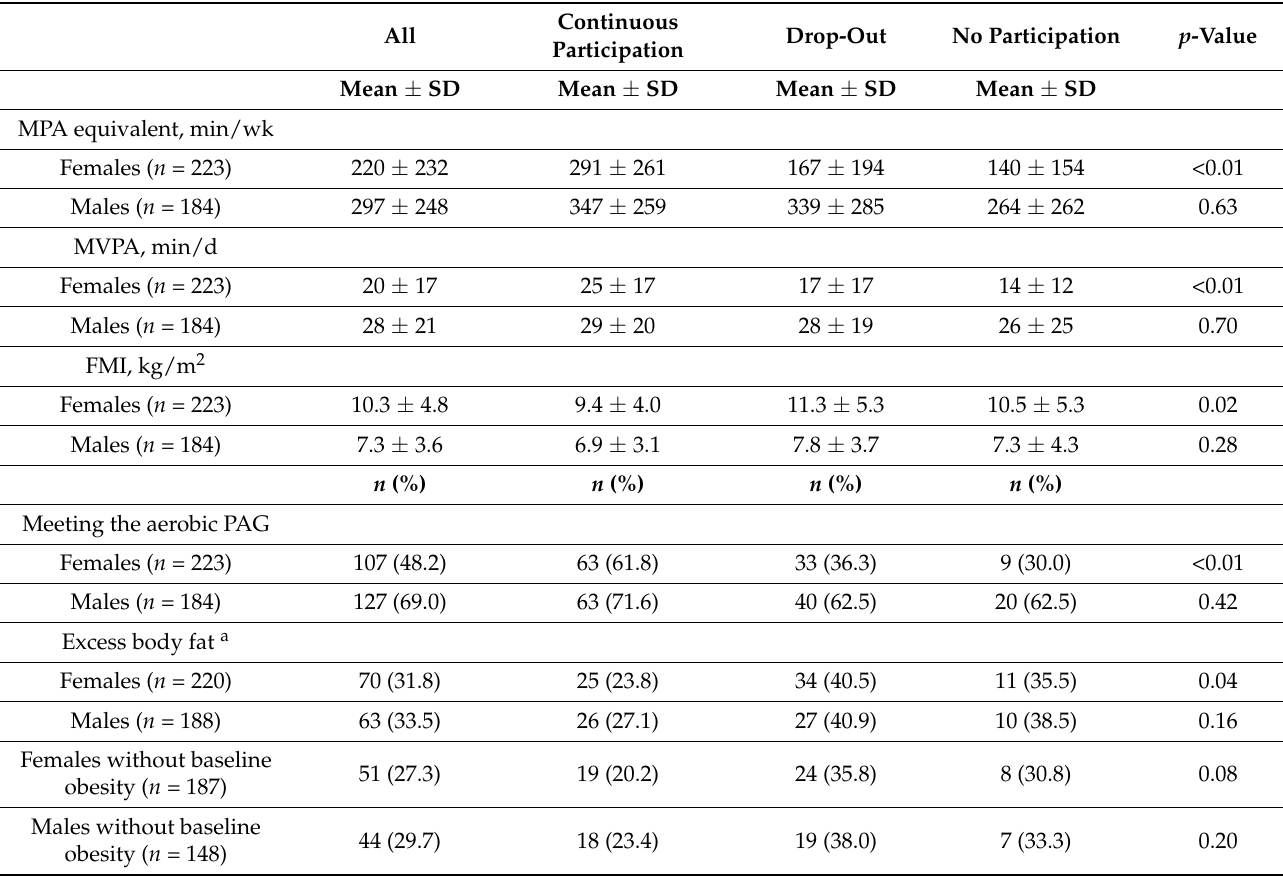
Table 2. Physical activity and adiposity in adulthood by youth sports participation patterns.